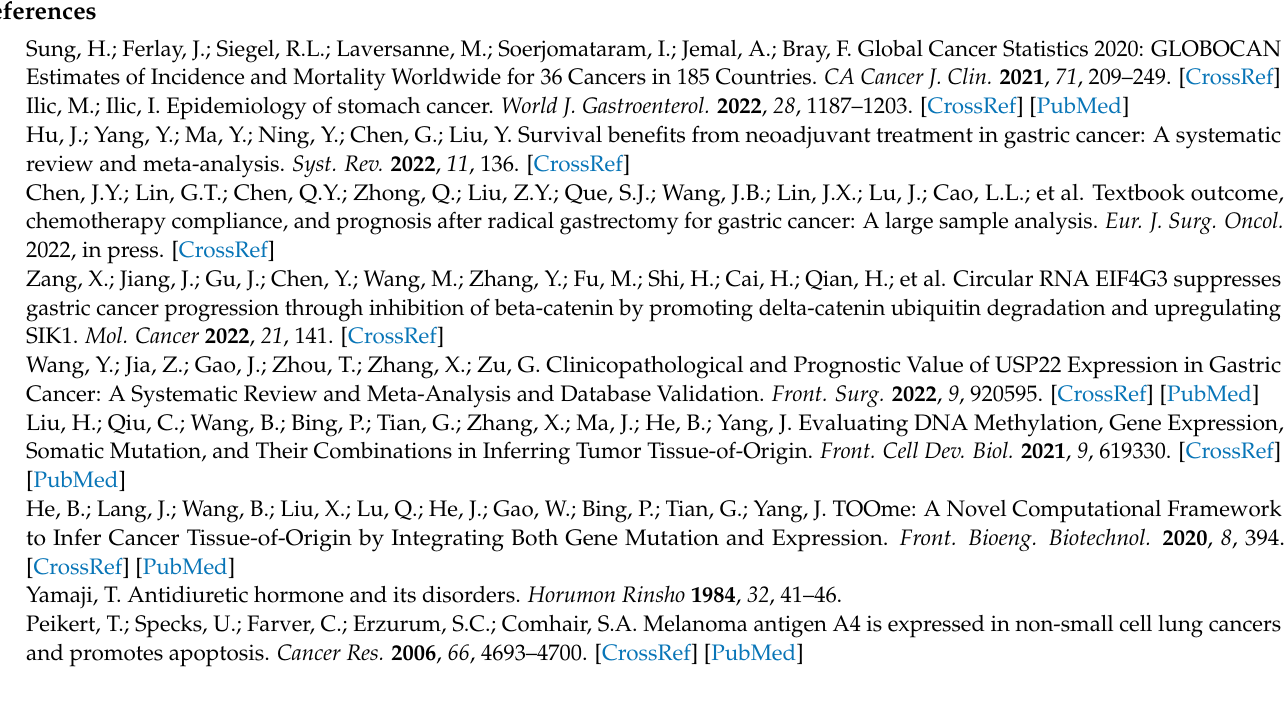
Supplementary Figure S2: The expression of MAGEA11 in STAD and normal tissues based on GEO databases. (* p < 0.05). Supplementary Figure S3: Survival analysis of MAGEA11 expression in STAD based on GEO database. Supplementary Figure S4: MAGEA11 mutation analysis. (A) MAGEA11 gene mutation signature in different tumors of TCGA. (B) The mutation type and the mutation frequency of the mutation site. (C) The mutation site (R235C/L) with the highest mutation frequency in the three-dimensional structure of MAGEA11 . (D-G) T cell CD4+ memory resting, T cell CD8+, B cell naive, and Neutrophil immune infiltration distribution between different sCNA status of MAGEA11